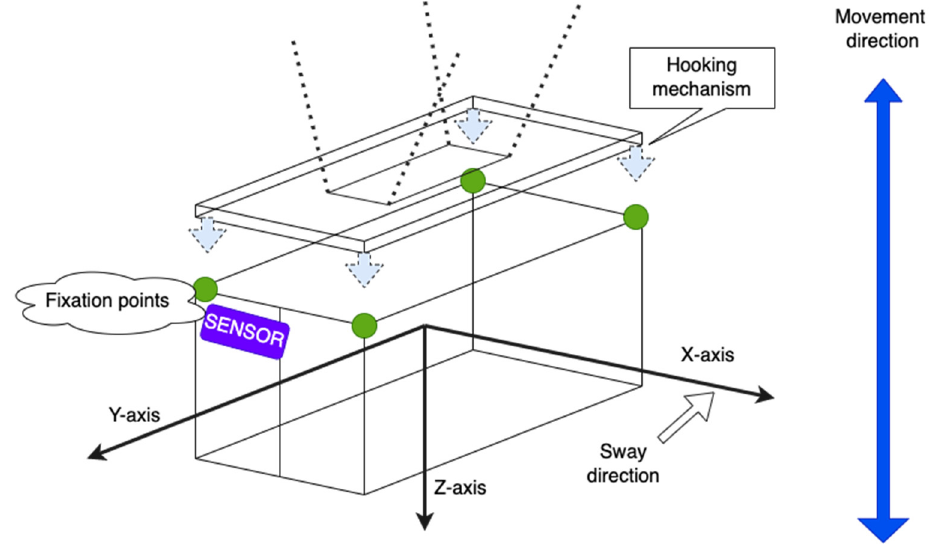
Figure 2. Diagram showing the path taken by the container during experimental case studies.